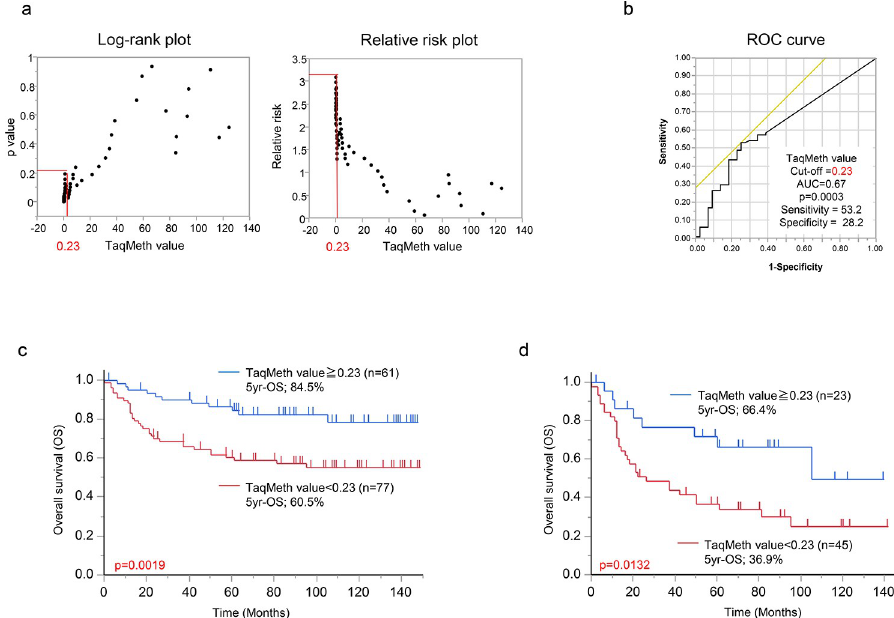
Fig 3. Prognostic analysis of MLH1 TaqMeth value in primary gastric cancer. (a) Log-rank plot analysis of the optimal cutoff value of MLH1 TaqMeth value in death event. (b) Receiver operating characteristics (ROC) curve to predict deaths also recapitulated the same optimal cut-off value of Log-rank plot analysis. (c) Kaplan-Meier survival curves for overall survival (OS) comparing gastric cancer patients with MLH1 TaqMeth value below 0.23 and those with MLH1 TaqMeth value equal to or over 0.23 ( P = 0.0019). (d) Kaplan-Meier survival curves for OS comparing gastric cancer patients with MLH1 TaqMeth value 0.23 in advanced gastric cancer patients (depth of invasion of pT2 or beyond), ( P =